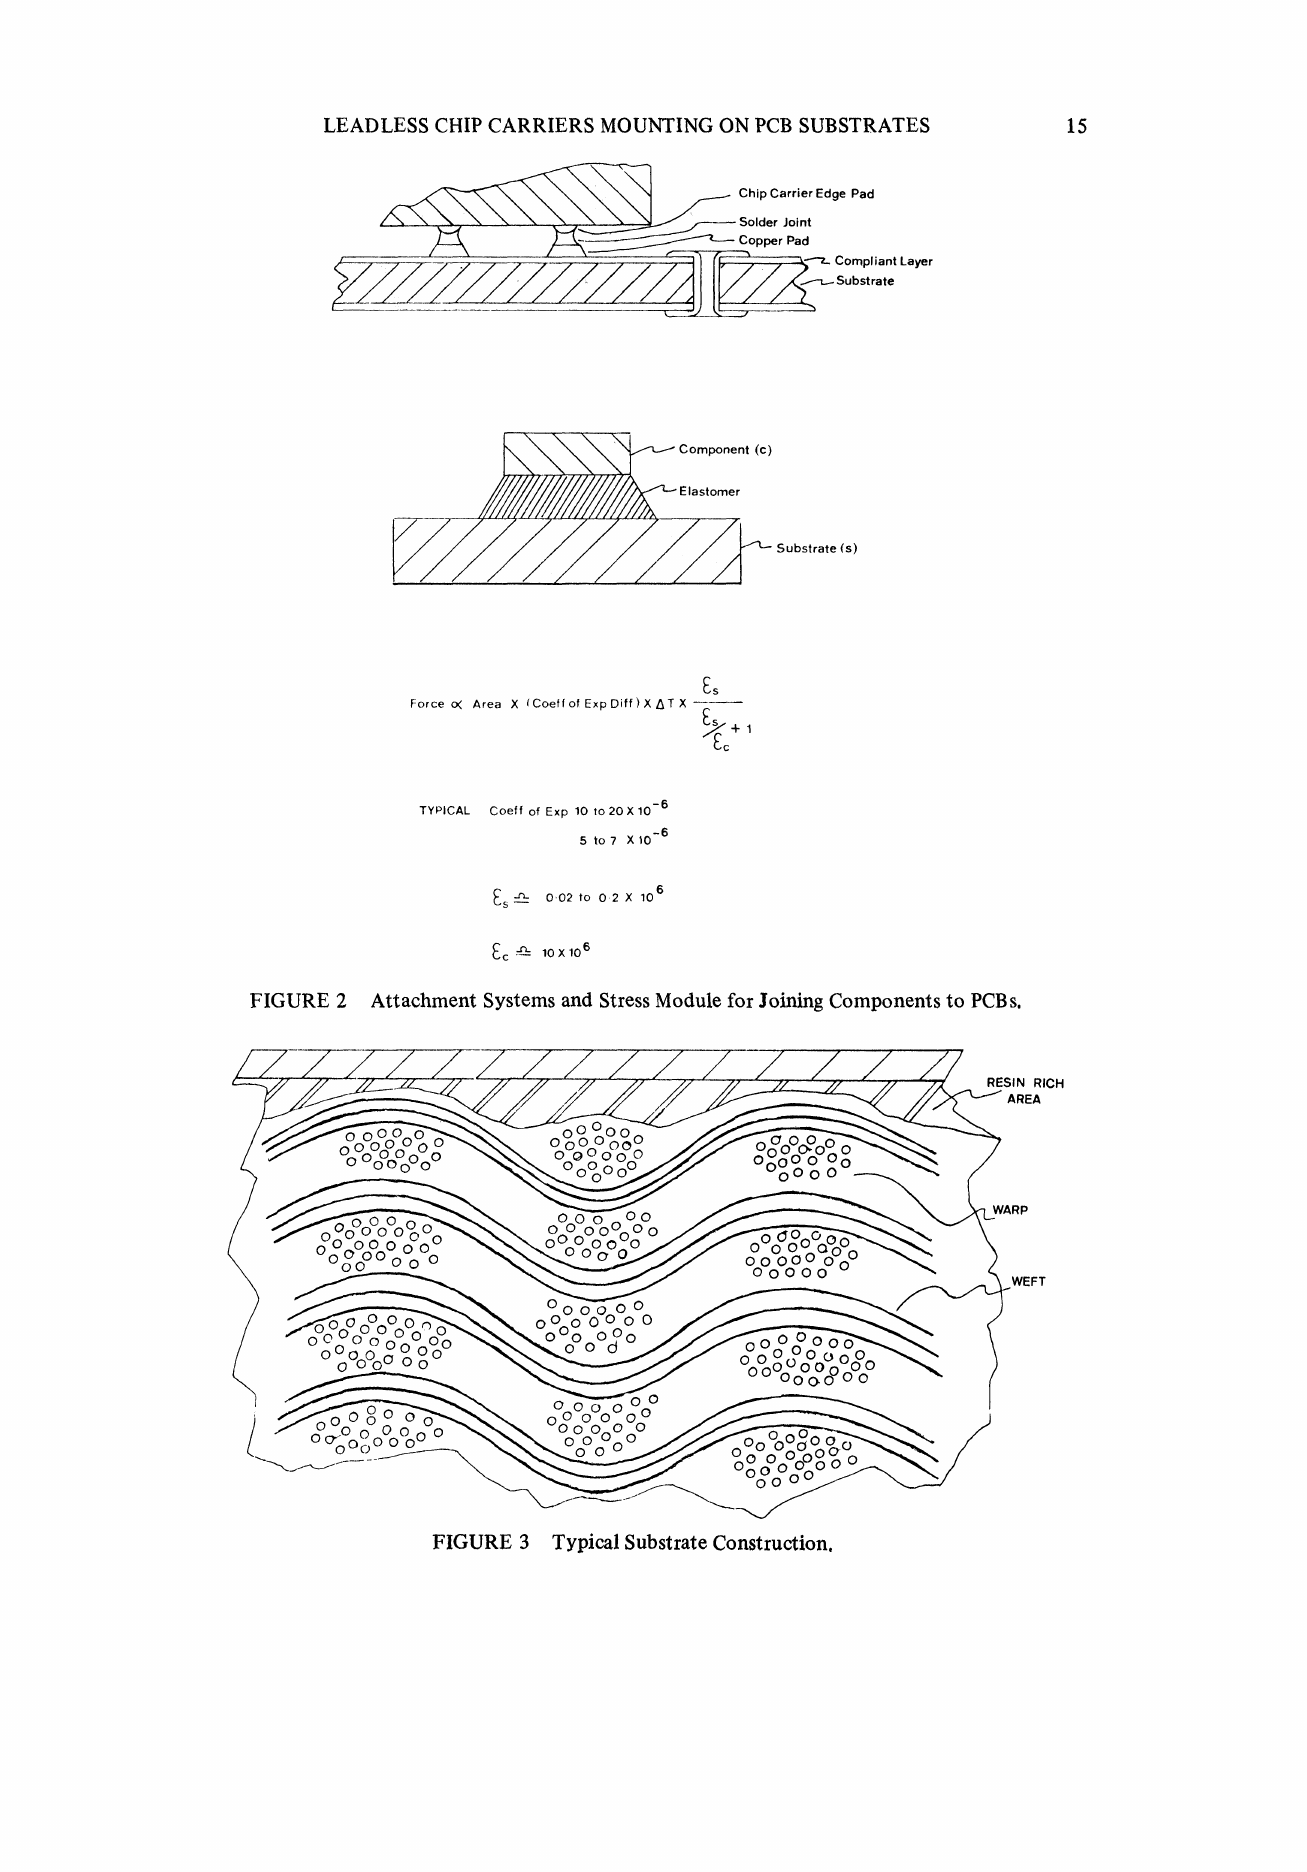
FIGURE 3 Typical Substrate